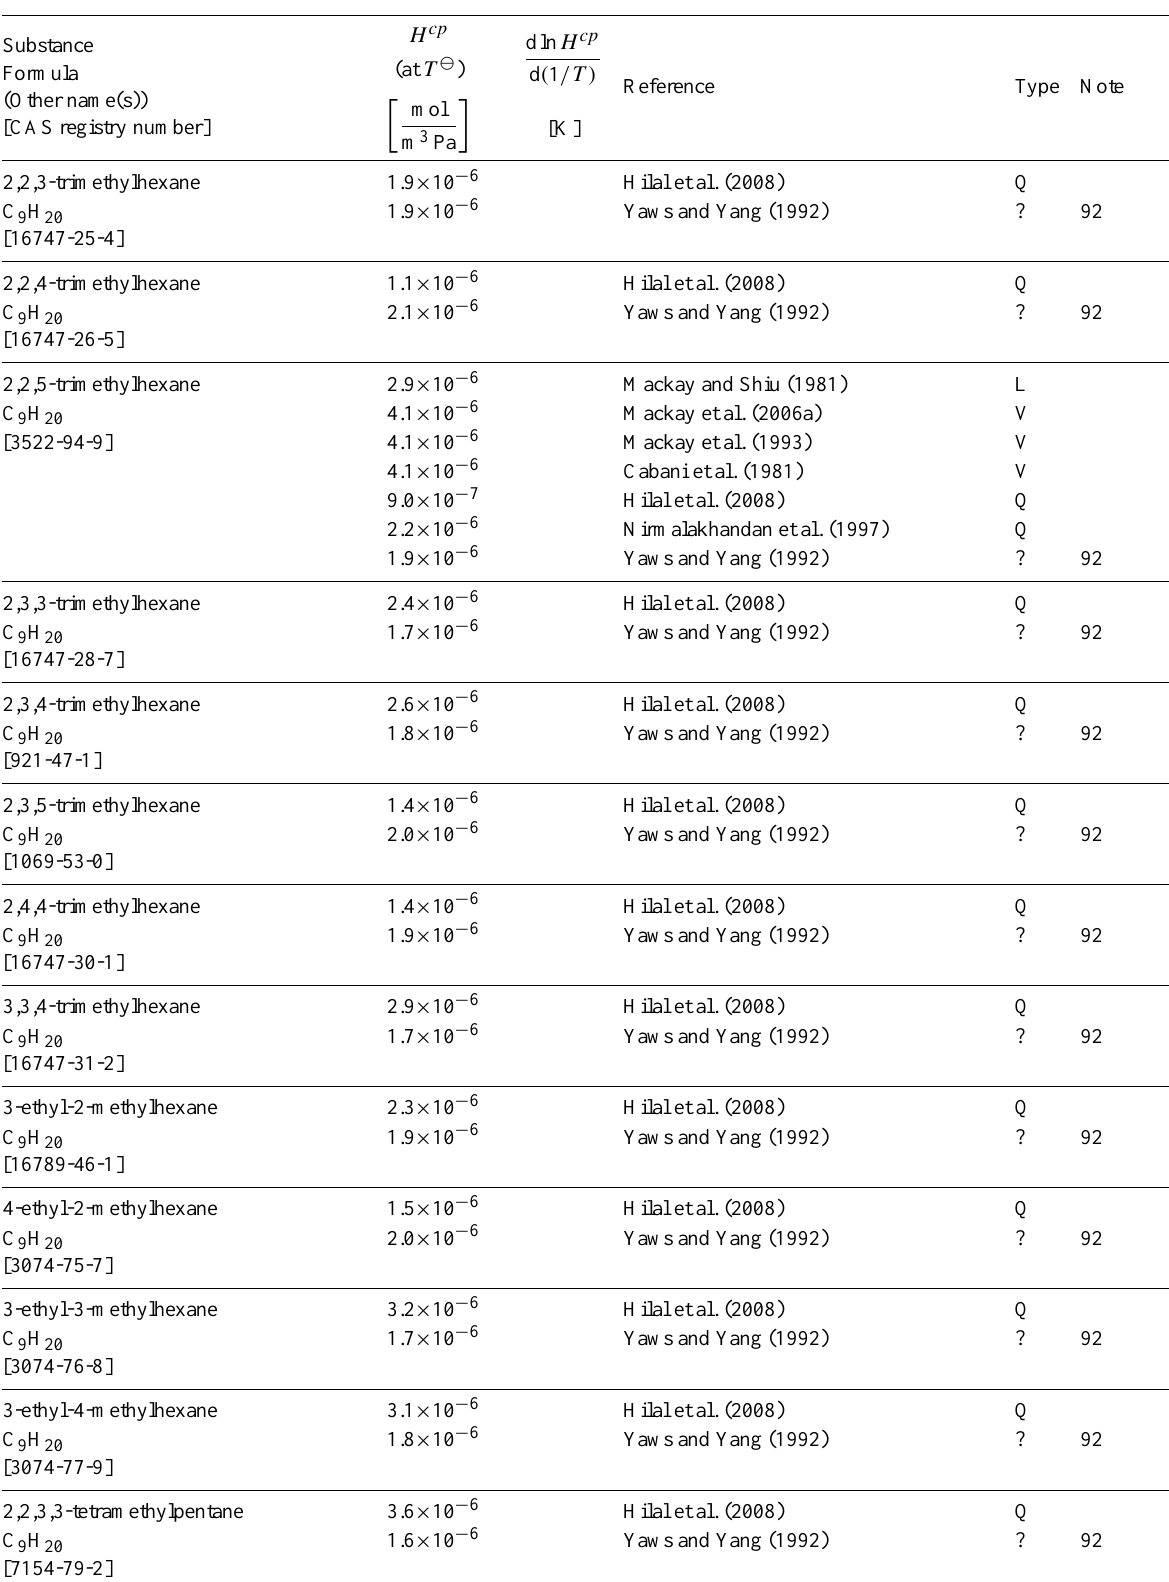
Table 6: Henry’s law constants for water as solvent